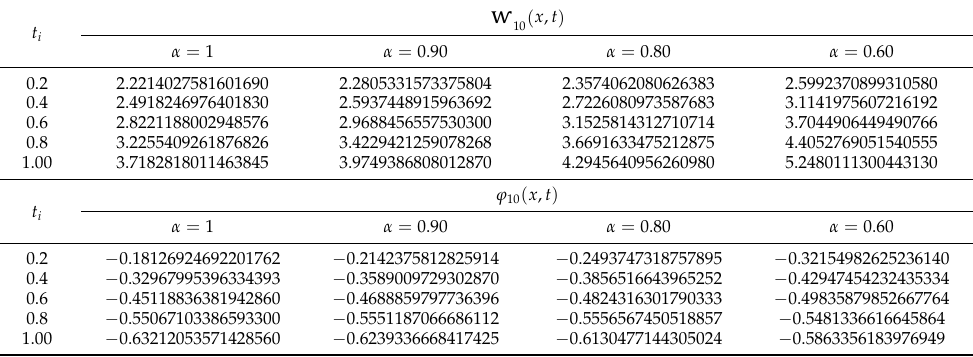
Table 3. Numerical results of approximated solutions, at n = 10, with different values of α , for Example